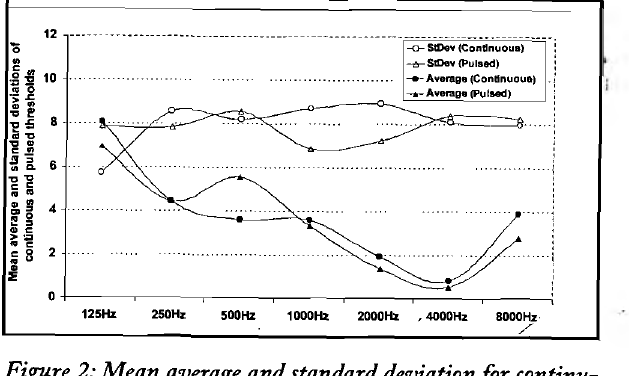
Figure 2: Mean average and standard deviation for continu­ ous andpulsed tones in the left ear (n=18) The average standard deviation for continuous tones was 8 dB in the left ear. The average standard deviation for pulsed tones was 7.9 dB in the left ear. Continuous